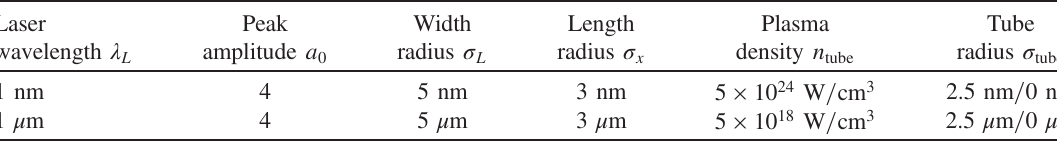
TABLE I. Summary of the laser and plasma parameters for our base